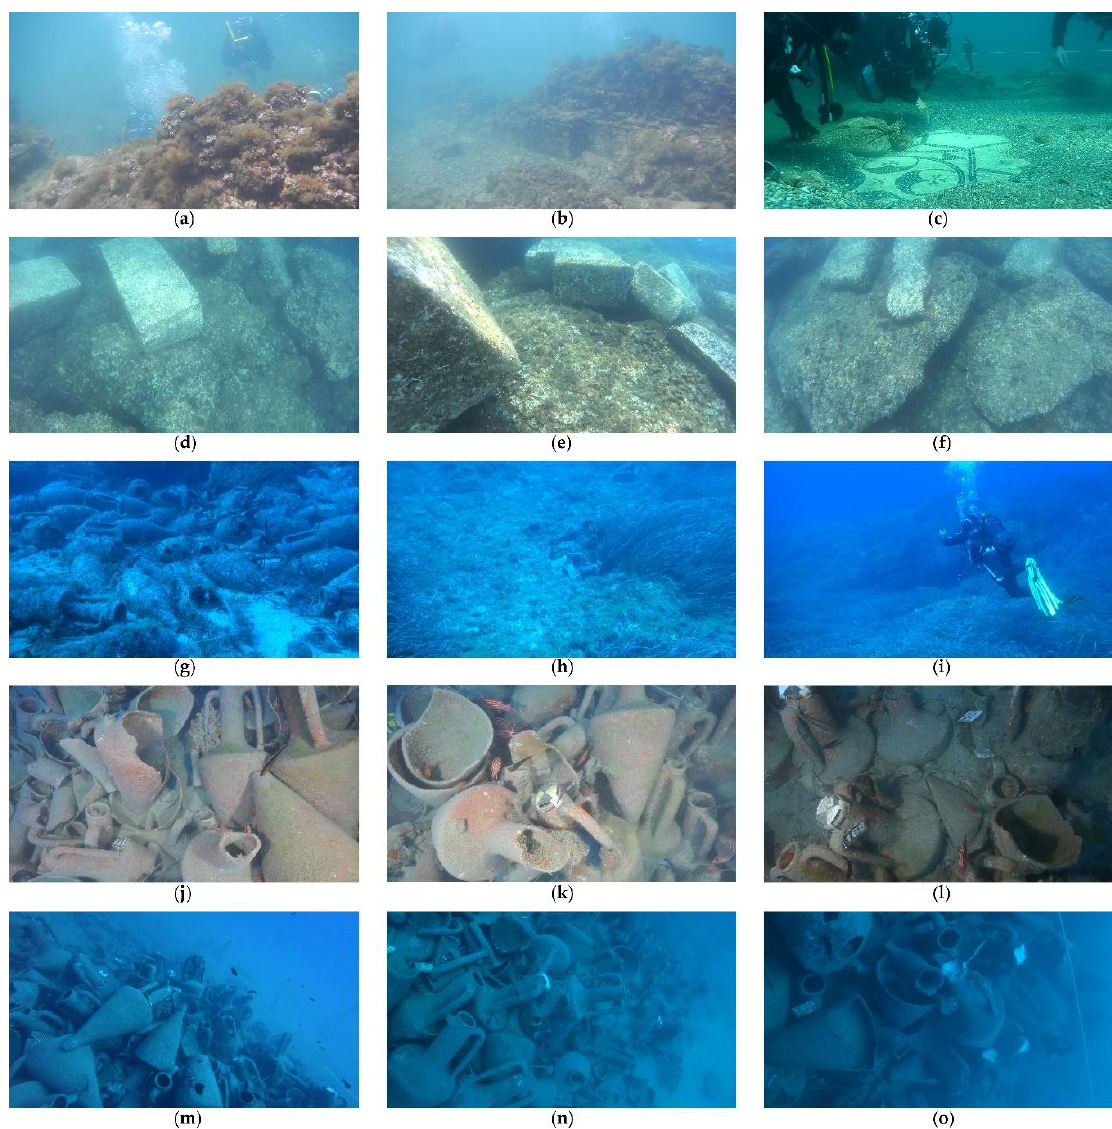
Figure 1. Underwater images dataset. ( a – c ) Images acquired at Underwater Archaeological Park of Baiae, named respectively Baia1, Baia2, Baia3. Credits: MiBACT-ISCR; ( d – f ) Images acquired at Cala Cicala shipwreck, named respectively CalaCicala1, CalaCicala2, CalaCicala3. Credits: